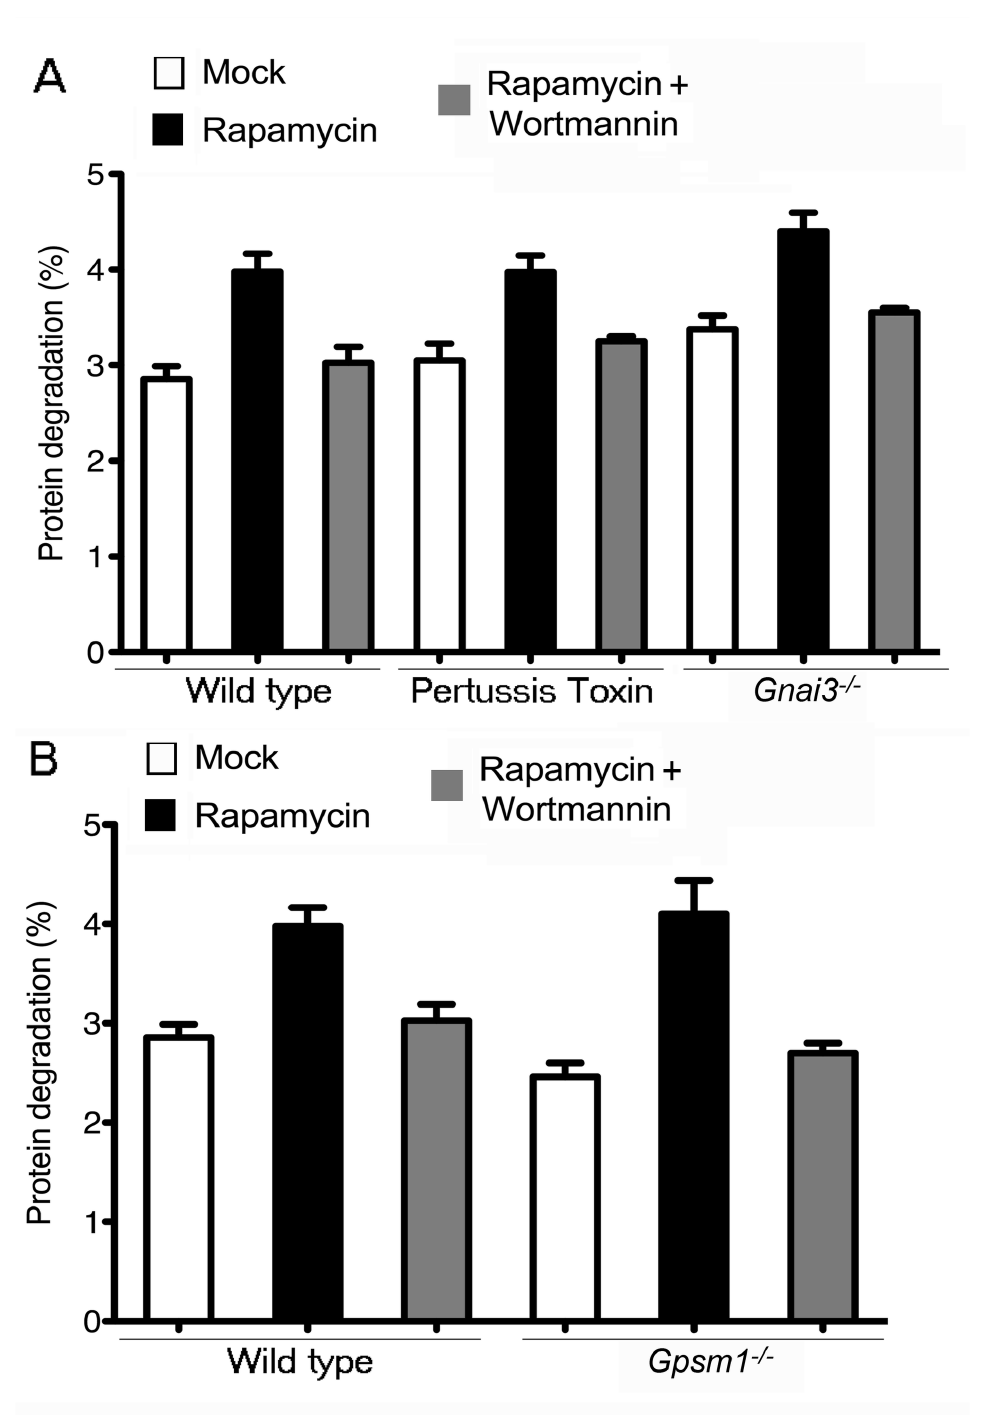
Figure 4. The lack of Gα , the lack of AGS3 or PTX treatment does not affect autophagic proteolysis in primary mouse i3 macrophages. ( A ) The analysis of autophagic proteolysis in BMDM prepared from wild type mice; wild type mice pre-exposed to PTX (200 ng/ml for 2h); or Gnai3 -/- mice, either not further manipulated, treated with rapamycin (50 μg/ml for 2h), or treated with wortmannin (1 μM for 2h) and rapamycin (50 μg/ml for 2h) ( B ) The analysis of autophagic proteolysis in BMDM prepared from wild type mice; or Gpsm1 -/- mice, either not further manipulated, treated with rapamycin (50 μg/ml for 2h), or treated with wortmannin (1 μM for 2h) and rapamycin (50 μg/ml for 2h). doi: 10.1371/journal.pone.0081886.g004 PLOS ONE |